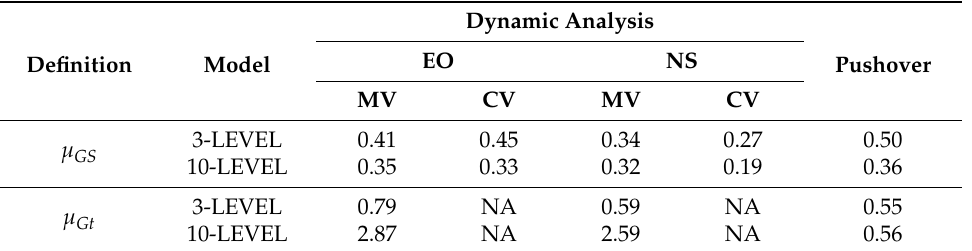
Table 10. Statistics of the R LG